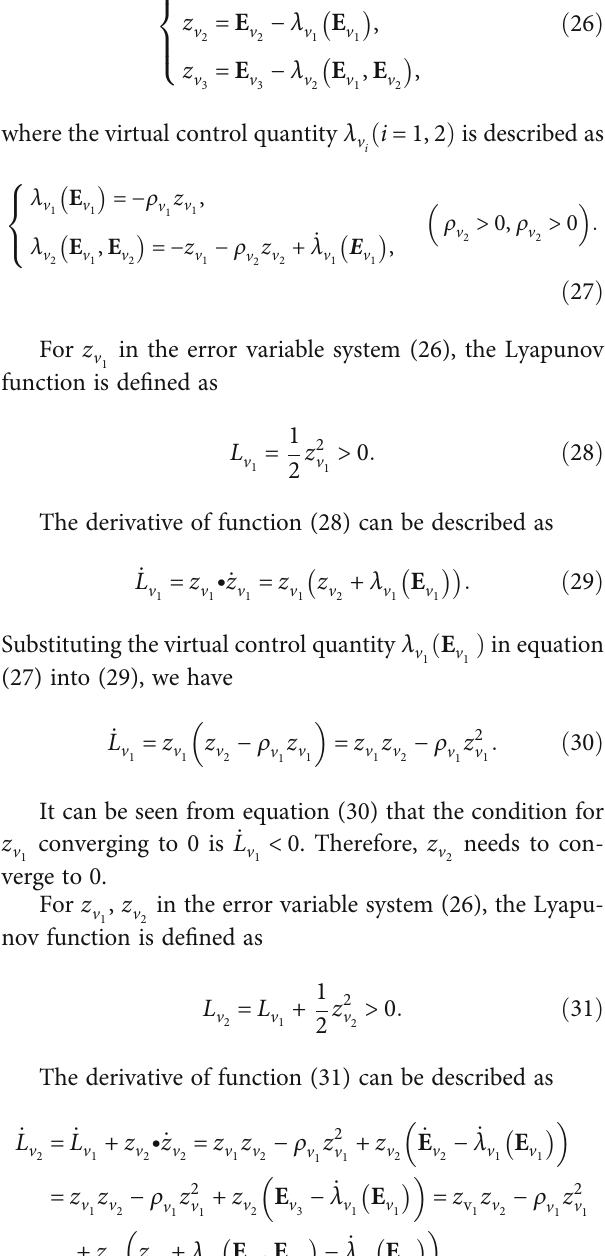
Table 1: Values of the TD parameters. Di ff erentiator The values of design